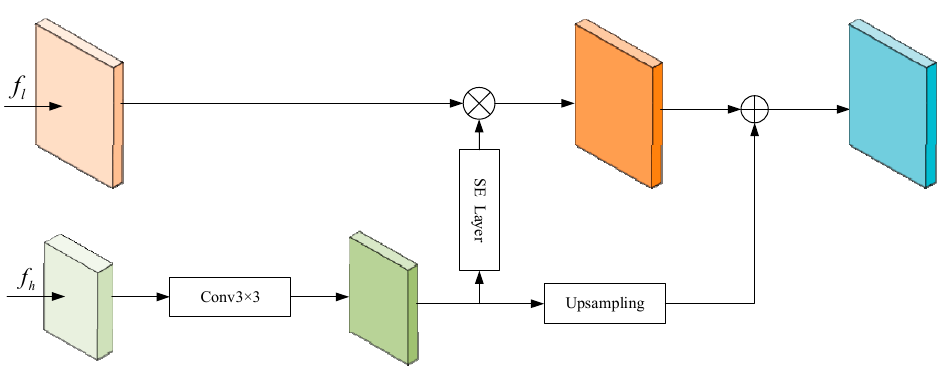
Figure 4. The architecture of the